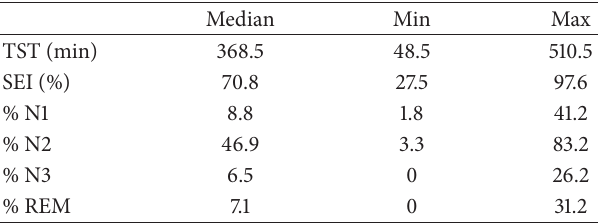
Table 2: The sleep quality parameters of the 42